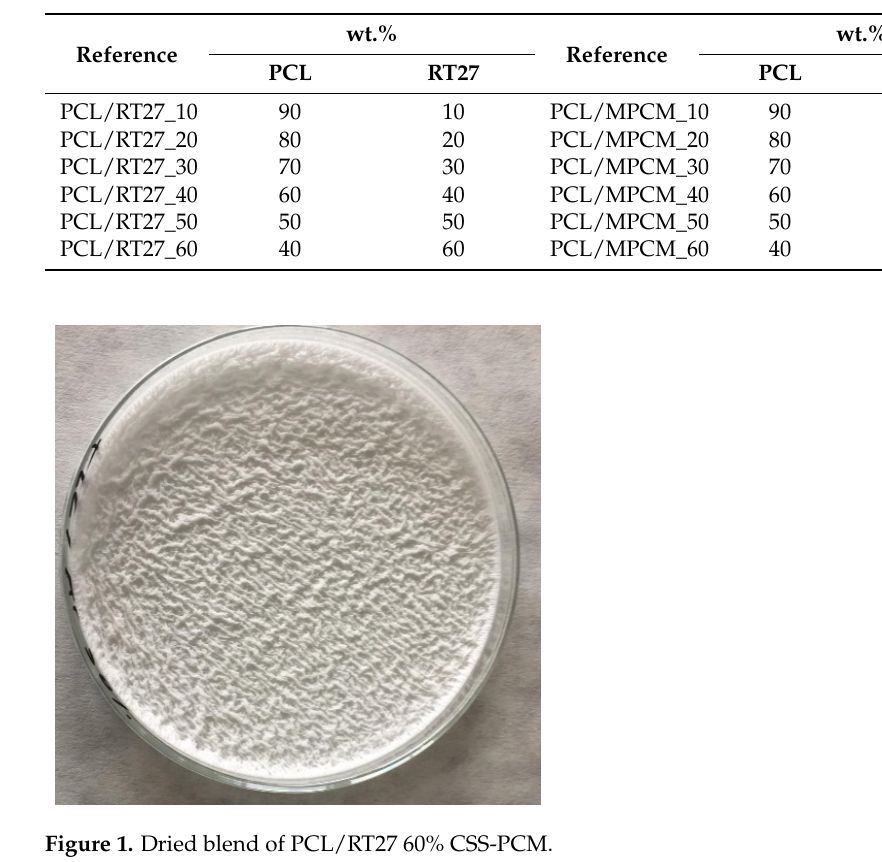
Table 2. Composition of the different blends manufactured.